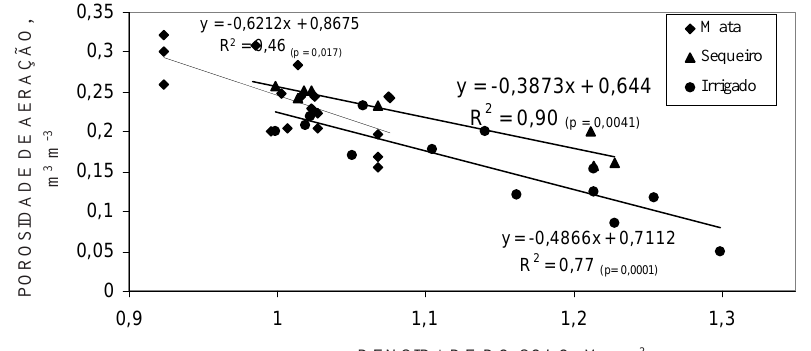
Figura 4. Porosidade de aeração, considerando a densidade do solo para os sistemas de uso e manejo 24 horas após a